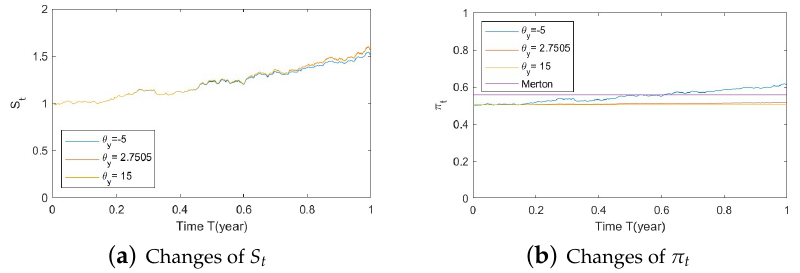
Figure A29. Illustrate the impact on ( a ) stock prices and ( b ) optimal stock allocations when varying θ y ( e . g ., θ y = − 5,2.7505,15 )